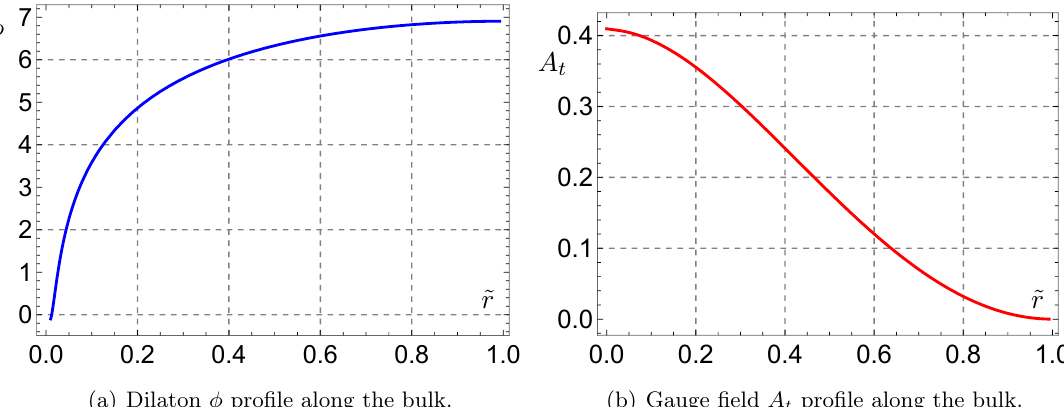
Figure 2 . Result of RG (cid:13)ow for the case (cid:13) ’ (cid:0) 1, (cid:14) ’ (cid:0) 1 and B=Q = 1. In this case, the magnetic (cid:12)eld is not required to be large. The horizon is at ~ r = 1, the boundary at ~ r =